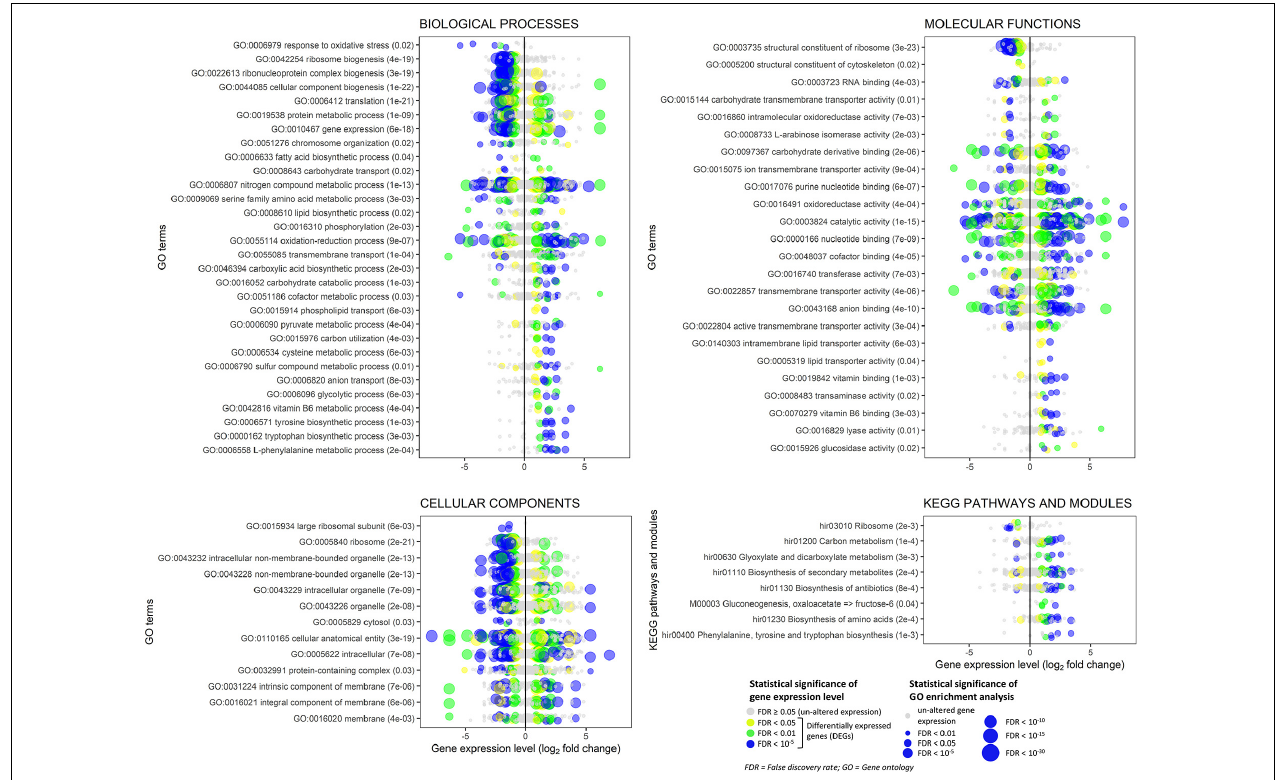
FIGURE 8 | Experiment L. Enrichment analysis of the gene ontology terms and the KEGG pathways and modules for the RNA-Seq experiment where Heterobasidion abietinum strain 10 was exposed to the volatile organic compounds (VOCs) emitted by Pseudomonas protegens CHA0 grown on Luria-Bertani agar (LBA) versus potato dextrose agar (PDA). For the biological processes and molecular functions, only 30 out of 133 and 24 out of 61 GO terms, respectively, are showed for better readability; these GO terms were representative nodes of the branches in the hierarchical graphs induced by all the enriched terms. Dots are gene expression means of three biological replicates (log 2 fold change compared to control). In parentheses next to the term description, the significance of enrichment analysis is reported